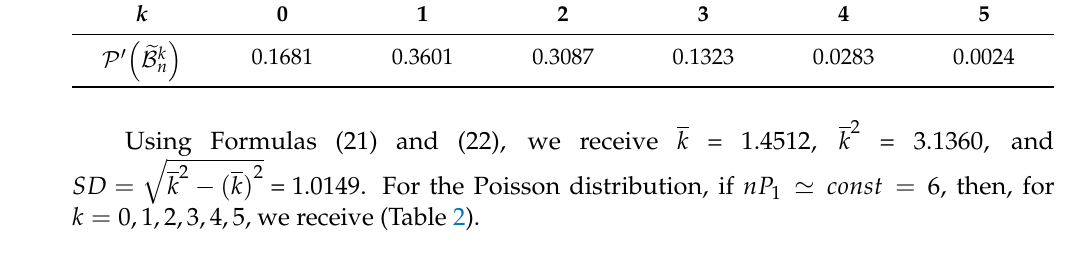
Table 2. Fragment of Poisson